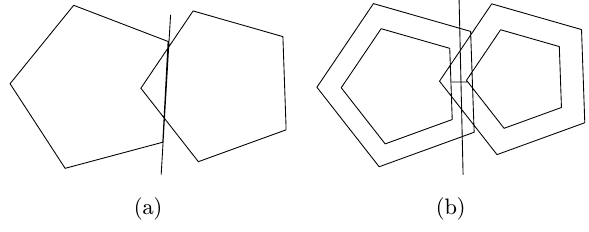
Fig. 2. The two SCHs become separable by a suitable reduction factor.